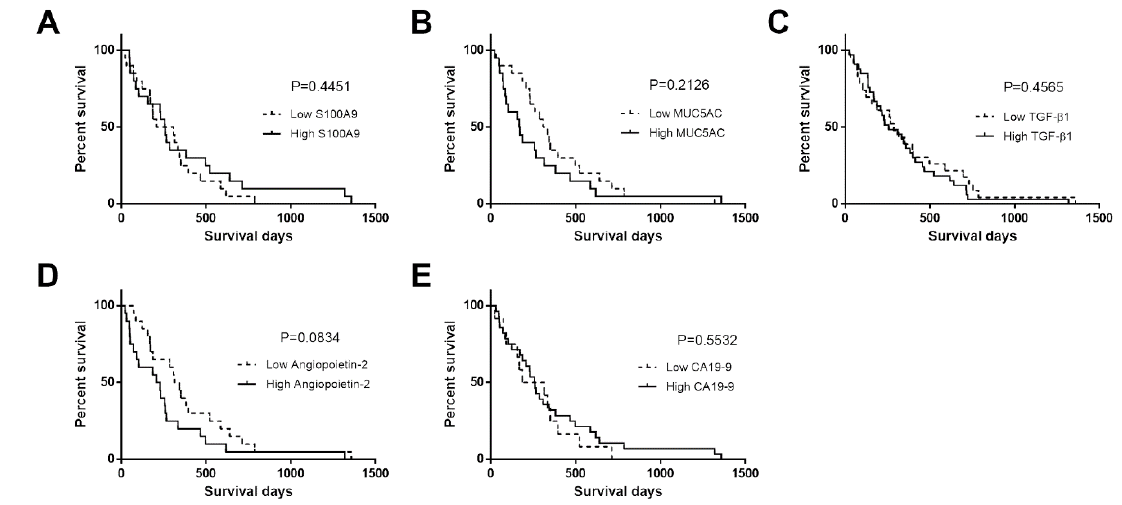
Figure 2. Overall survival (OS) analysis according to Kaplan–Meier method with a log rank test calculated for S100A9 ( A ), MUC5AC ( B ), TGF- β1 ( C ), angiopoietin-2 ( D ), and CA19-9 ( E ). The p value < 0.05 was considered statistically significant.